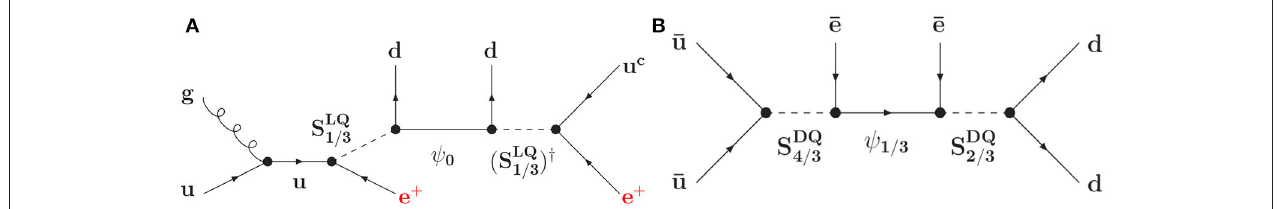
FIGURE 43 | Example diagrams of L violation processes with (A) leptoquark S LQ 1 / 3 and (B) diquarks S DQ 4 / 3,2 / 3 [526, 527]. The singlet fermion ψ 0 in the left panel leads to Type I